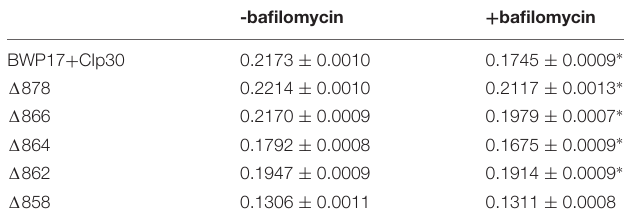
TABLE 1 | Pma1p truncation masks the effects of bafilomycin A1 on growth. TABLE 2 | Biofilm formation by Pma1p truncation mutants as measured by crystal violet